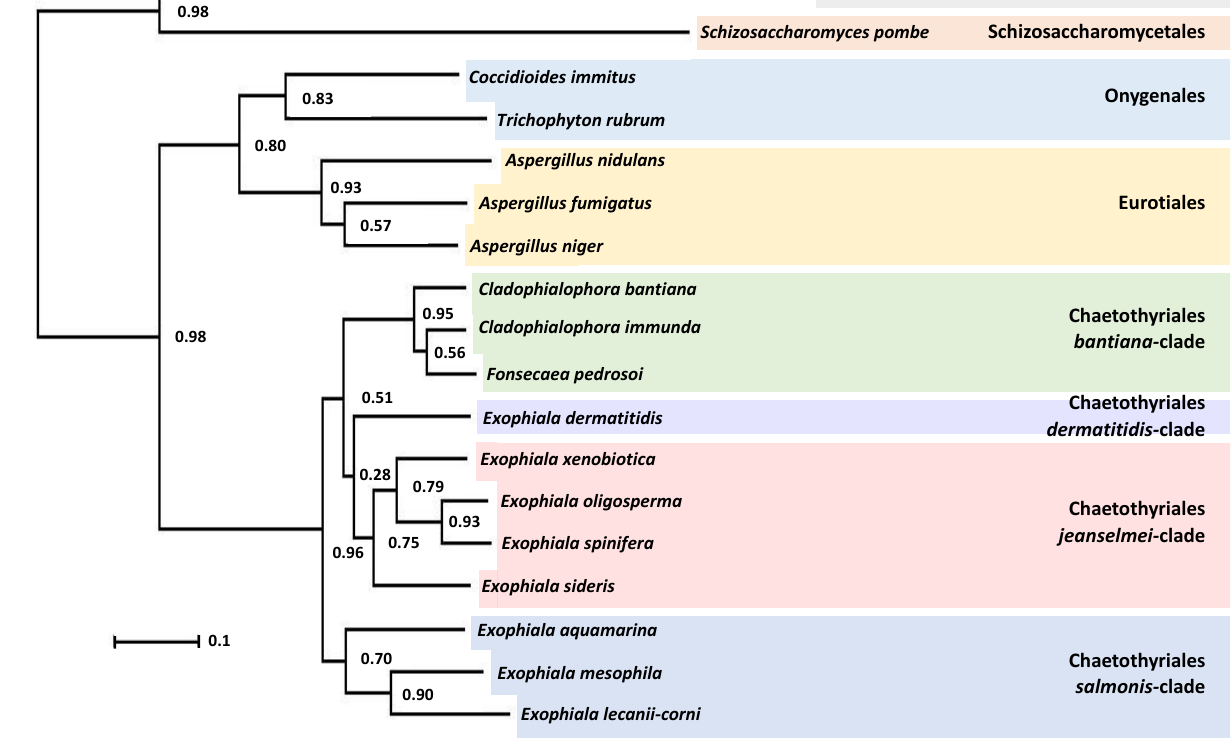
Figure 5. Rooted species tree inferred using OrthoFinder displaying the relative placement of E. lecanii-corni among the various clades of Chaetothyriales and other well-characterized ascomycetous species. Numbers at internal nodes refer to bootstrap support